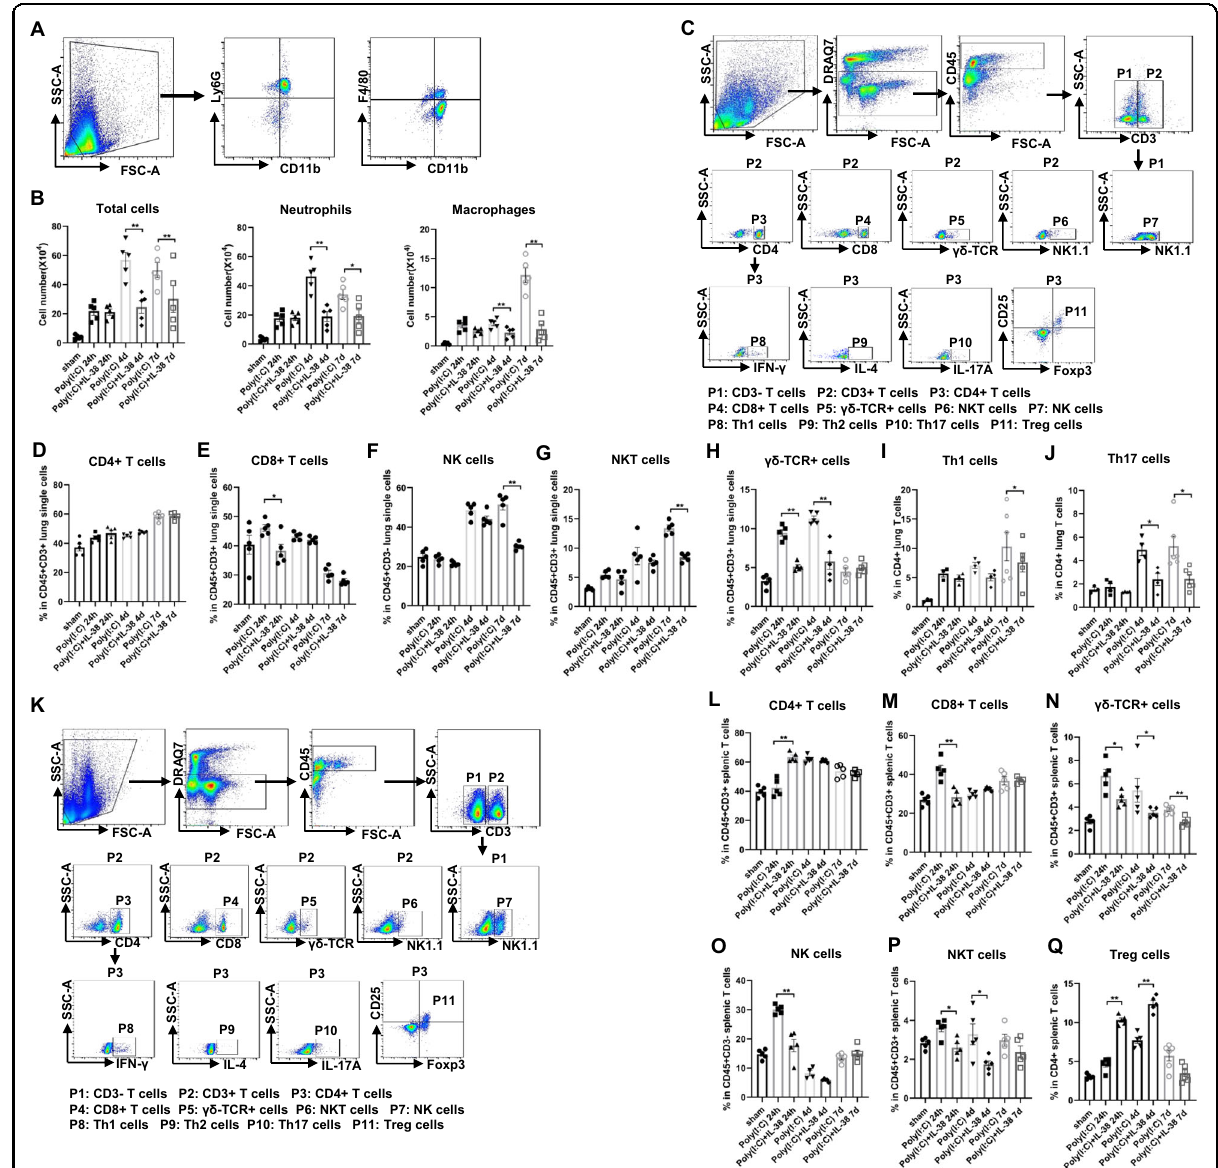
Fig. 4 IL-38 reduces leukocyte in fl ux and activation during poly(I:C)-induced lung injury. Bronchoalveolar lavage fl uid (BALF), lung, and spleen ( n = 5 each group) were collected on day 1, 4, and 7 after poly(I:C) injection. ( a ) Gating strategies for the analysis of myeloid cells from BALF cells based on CD11b, F4/80, and Ly6G expressions. ( b ) Number of total cells, neutrophils, and macrophages were counted at indicated times. ( c , k ) Gating strategies for the analysis of lymphoid cells from lung and spleen, respectively. Cells were gated based on CD45, CD3, CD4, CD8, γδ -TCR and NK1.1, IFN- γ , IL-4, IL-17A, CD25, and Foxp3 expression for lymphoid populations. DRAQ7 was used to exclude dead cells. ( d – j , l – q ) Percentage of lymphoid cell populations in lung and spleen at indicated time points. Each symbol represents an individual mouse. Data (means ± SEM) are representative of three independent experiments. Mann-Whitney test was used to compare the differences between groups. * p < 0.05, ** p < 0.01, and *** p <